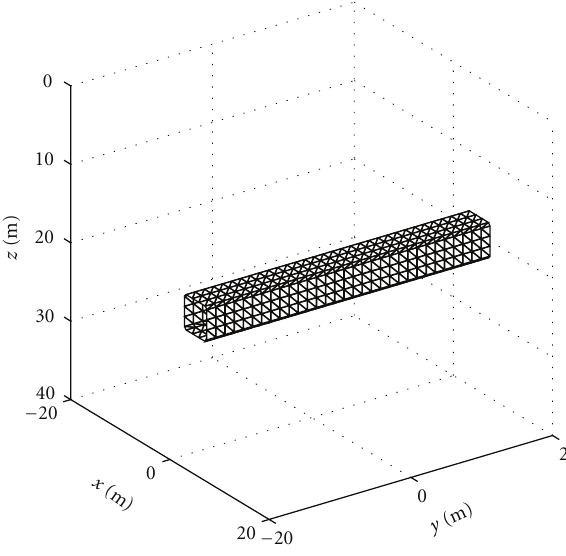
Figure 2: The adopted numerical